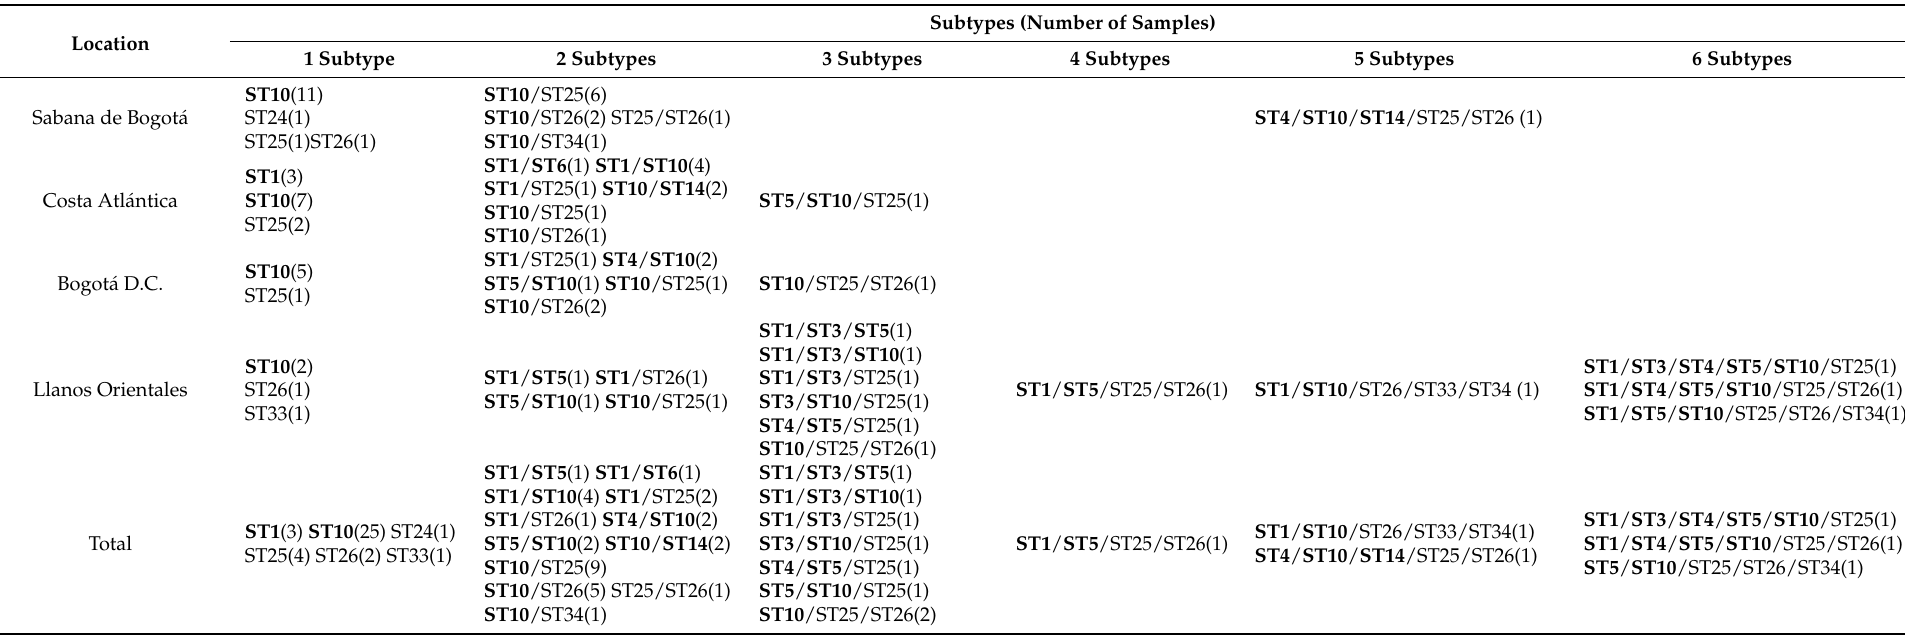
Table 5. Combination of STs observed in horses in Colombia at each location. Subtypes in bold denote those previously identified in